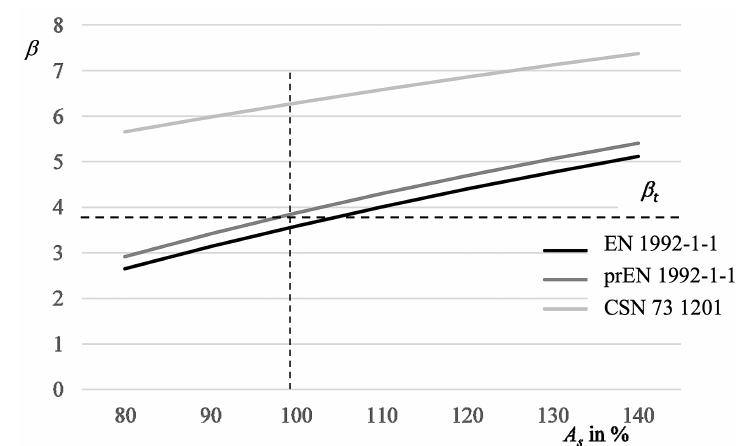
Figure 2. Variation of the reliability index β versus the percentage of required area of reinforcement of a slab considering EN 1992-1-1, prEN 1992-1-1 and CSN 73